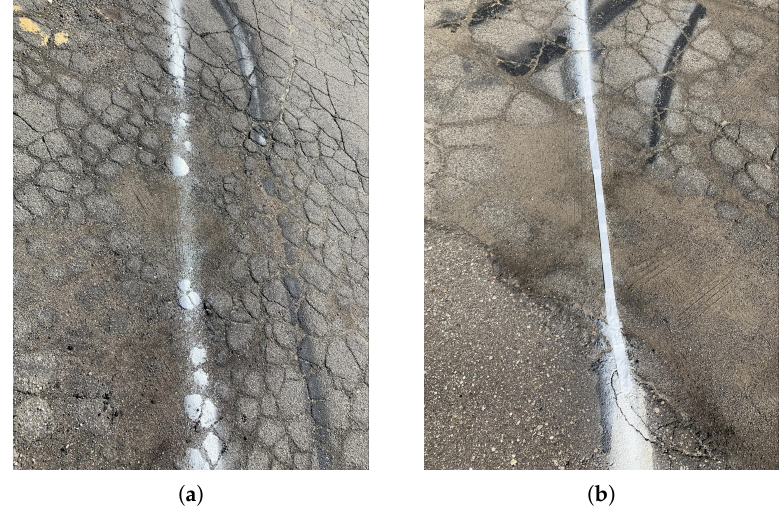
Figure 21. The Lot H Course contains many broken lines where there should be solid lane lines. This mimics real-life, worn road conditions: ( a ) Broken white lane line is shown in the above image. The deteriorated road conditions are also seen; ( b ) A strip of reflective white tape is secured creating a more stable line to detect and track.